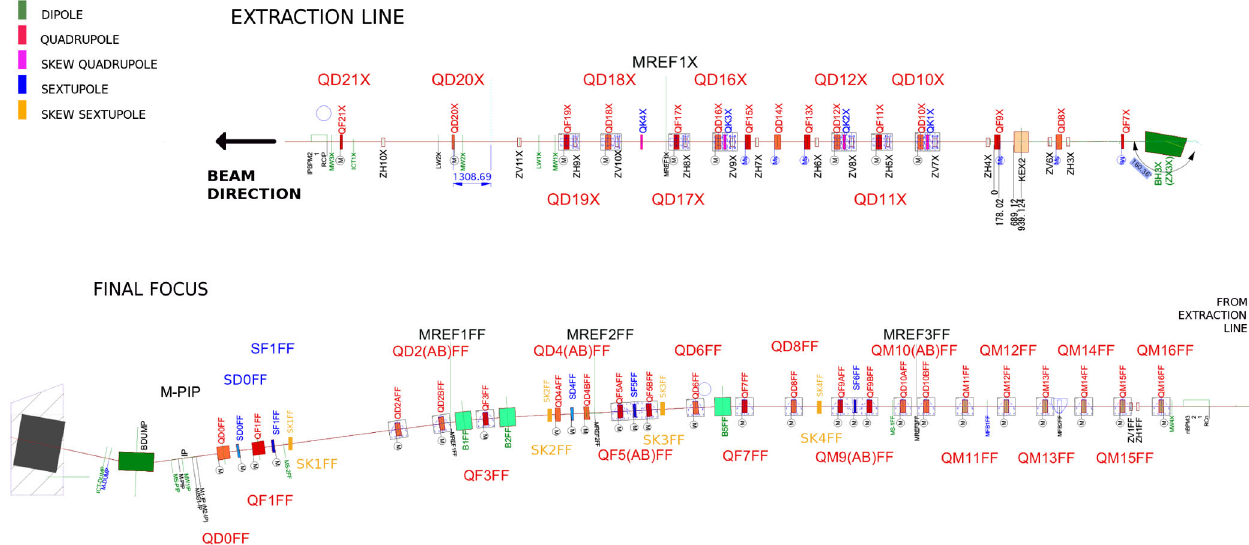
FIG. 1 (color online). Scheme of the ATF2. The beam line on the left represents the extraction beam line (EXT). The beam line on the right represents the FFS as the continuation of the EXT line (the figure is courtesy of